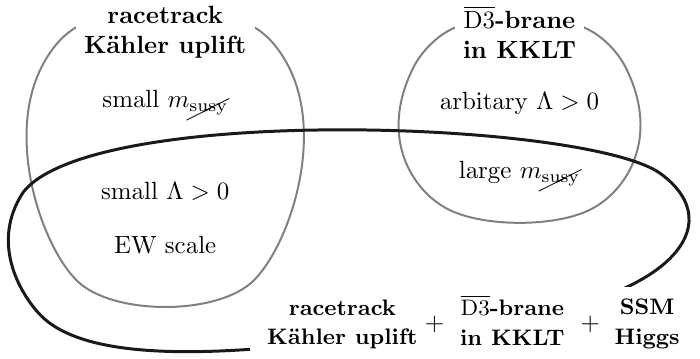
Figure 1 . Relations among the 3 pillars of the model: the KKLT scenario with D3 -branes, the racetrack Kähler uplift model and the supersymmetric standard model with the two electroweak Higgs doublets. In the absence of the soft SUSY-breaking terms for the Higgs fields, one can have an exponentially small Λ > 0 or a large enough SUSY-breaking scale m (cid:8)(cid:8)